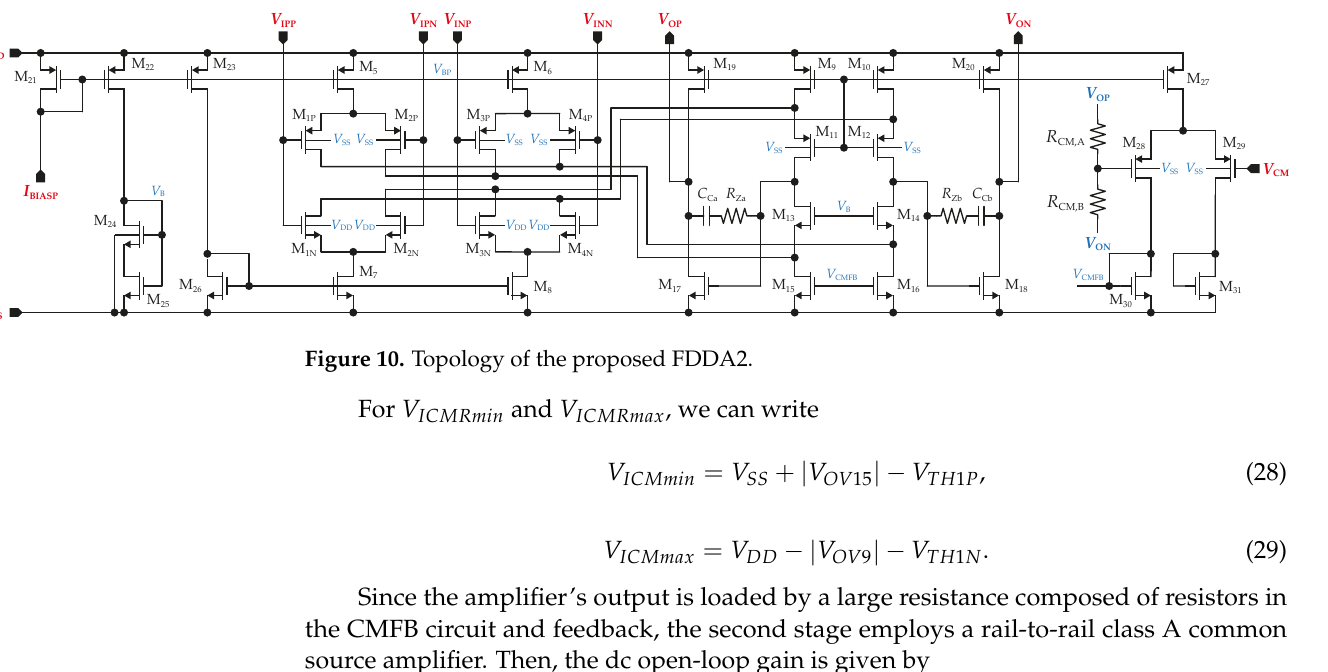
Figure 9. AC analysis of the circuit from Figure 7, including the corners of the MOSFETs, resistors, and capacitors, where ( a ) input-referred noise, ( b ) input impedance (only MOSFET corners), ( c ) gain including phase, and ( d ) histogram of CMRR are shown. Process corners of MOSFETs are listed in the order of NMOS-PMOS, where S is slow, T is typical, and F is the fast corner.